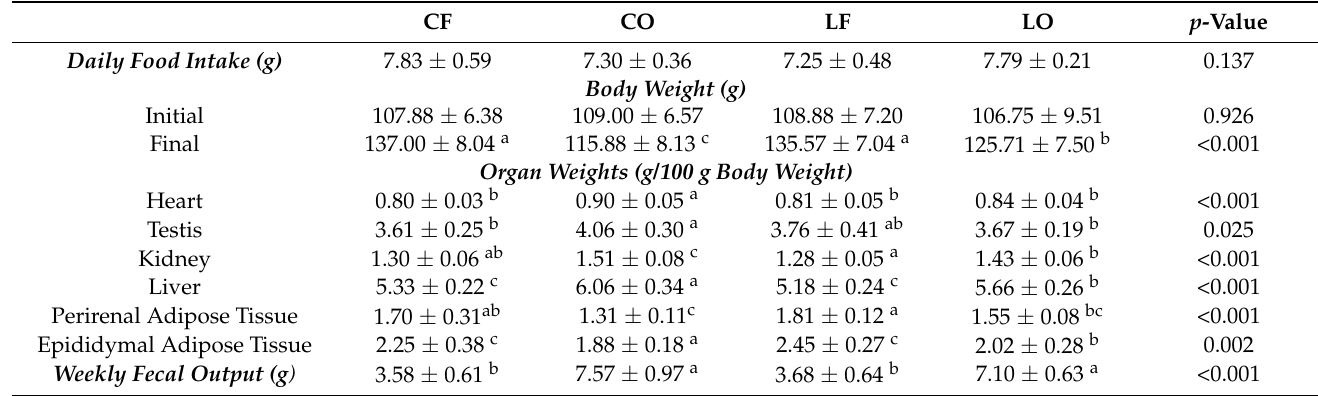
Table 3. Food intake, body weight, organ weight, and fecal output of hamsters fed one of the four diets: CF, fresh corn oil; CO, oxidized corn oil; LF, fresh lard; LO, oxidized lard.